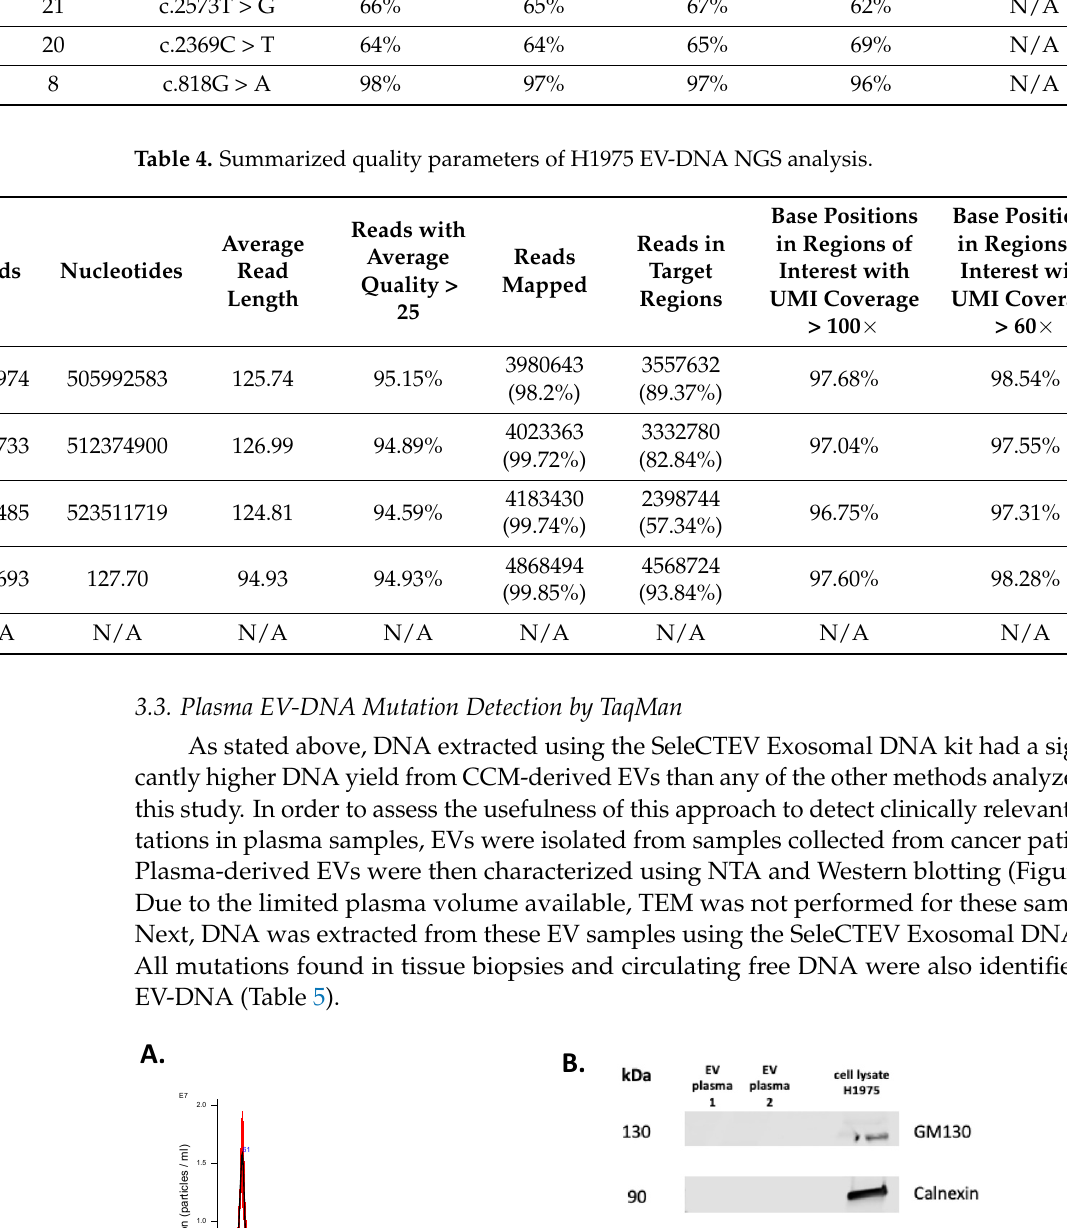
Table 3. Mutation detection in H1975 EV-DNA by NGS. Table 4. Summarized quality parameters of H1975 EV-DNA NGS analysis.